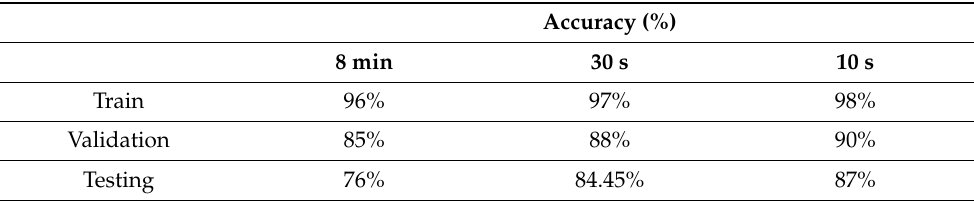
Table 8. Accuracy results for model 1 (training vs. validation vs. testing).